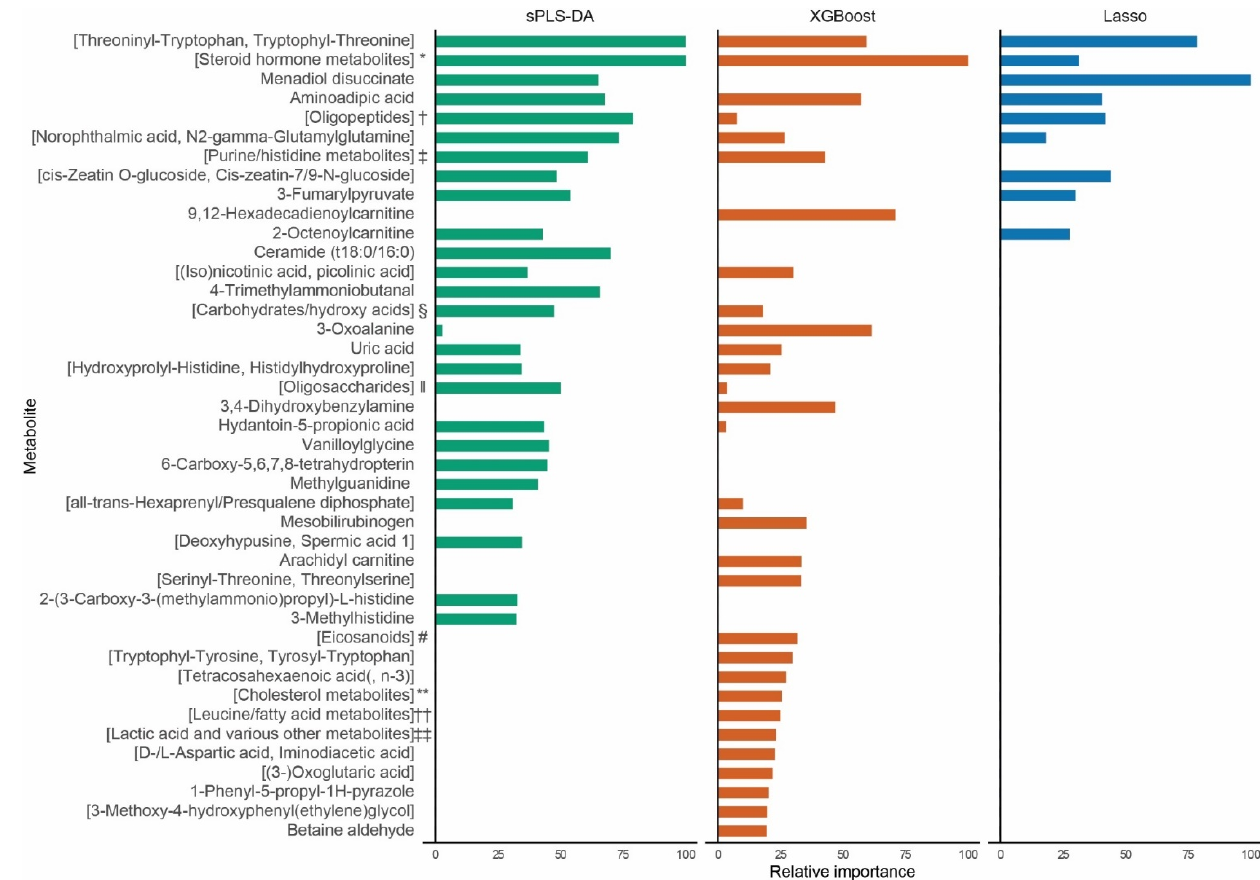
Figure 1. Relative variable importance. Top 25 metabolites in each model ordered by their mean relative importance across the models, showing their relative importance scaled to the most im- portant metabolite in each model. The sPLS-DA and XGBoost models show 26 and 30 metabolites, respectively, as these metabolites were included in the top 25 of other models. Two metabolites selected by the Lasso logistic regression, Ceramide (t18:0/16:0) and 4-Trimethylammoniobutanal, are not visible owing to their very small coefficients ( − 8.67 × 10 − 7 and 1.82 × 10 − 6 , respectively). Metabolites annotated to the same mass spectrometry peak are denoted in square brackets. sPLS-DA, sparse partial least squares discriminant analysis. * includes 2-methoxy-estradiol-17b 3-glucuronide and 4-hydroxyandrostenedione glucuronide. † includes aspartyl-(iso)leucine, L-beta-aspartyl-L- leucine, (gamma-)glutamylvaline, and (iso)leucyl-aspartate. ‡ includes 1,3-dimethyluracil, imida- zolepropionic acid, and (Pi-)methylimidazoleacetic acid. § includes (S)-3,4-/2,4-dihydroxybutyric acid, 4-deoxythreonic/-erythronic acid, erythrose, and L-erythrulose. (cid:107) includes dextrin,